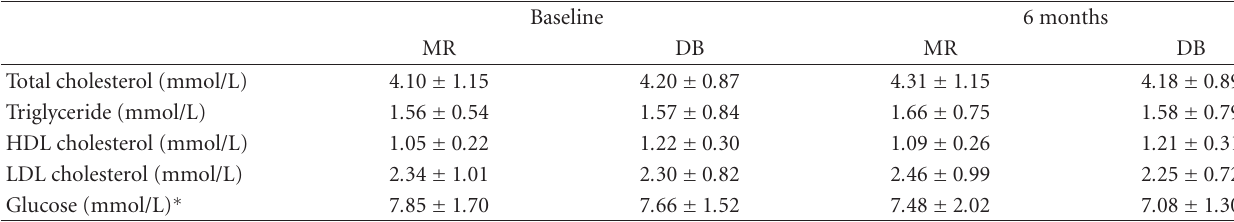
Table 7: Lipids and glucose at baseline and 6